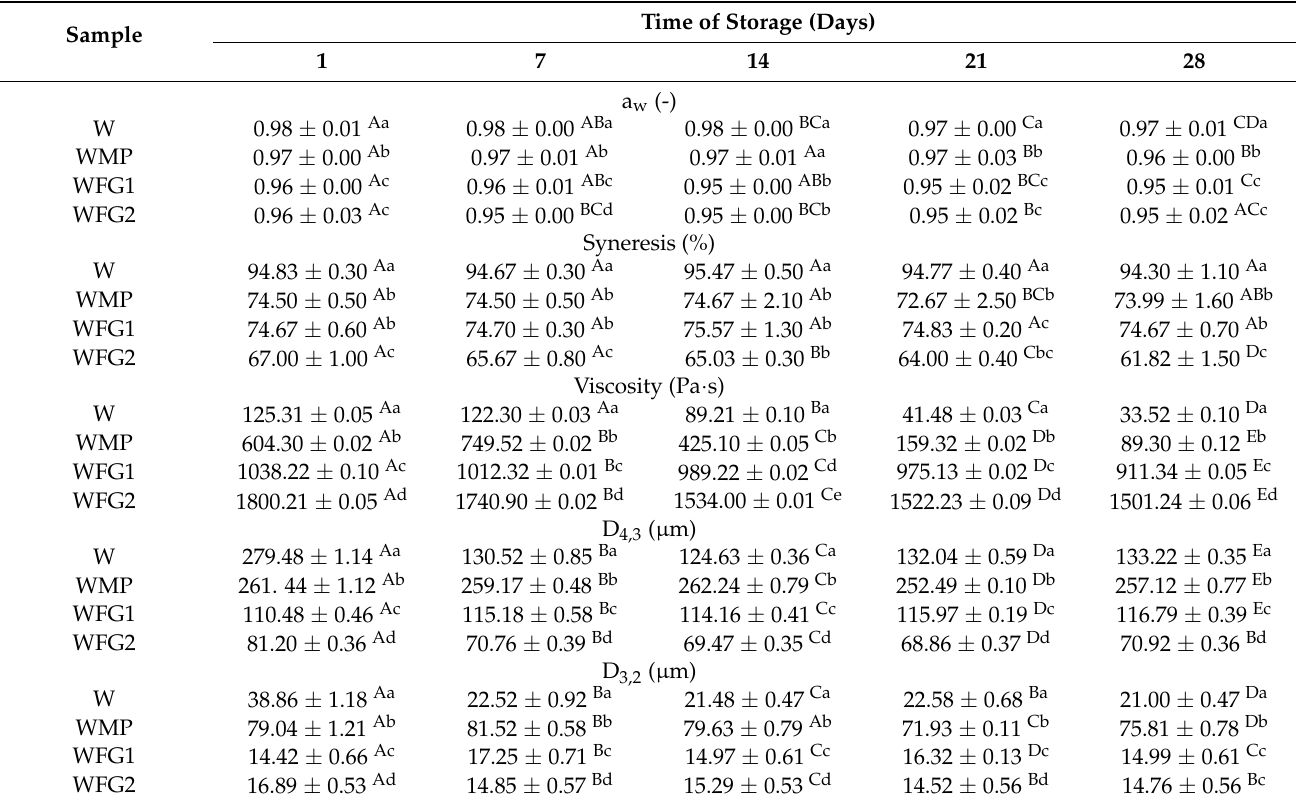
Table 3. Water activity, syneresis, viscosity and particle sizes of the samples during storage